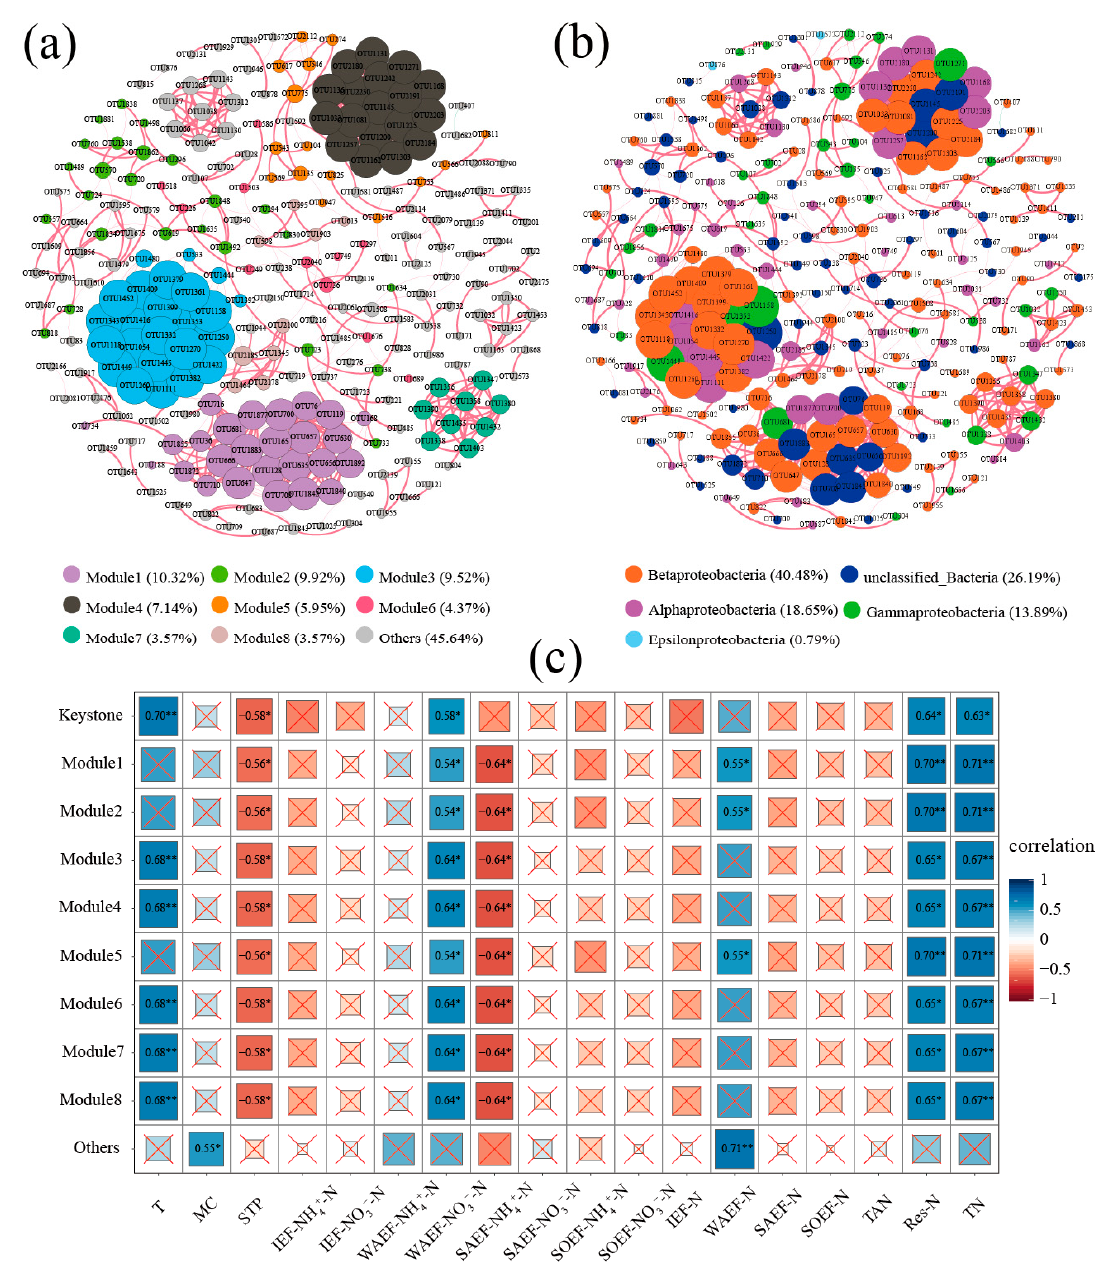
Figure 6. Network visualizes the OTU–OTU interactions and correlation between module and environmental factors in Baiyangdian Lake. Positive correlations were displayed in red and negative correlations were displayed in green (Spearman’s |R| > 0.9, p -value < 0.001). The size of each node is proportional to the degree. ( a ), OTU–OTU interactions (The nodes were colored according to modularity classes.); ( b ), OTU–OTU interactions (The nodes were colored according to class level.); ( c ), correlation between module and environmental factors.